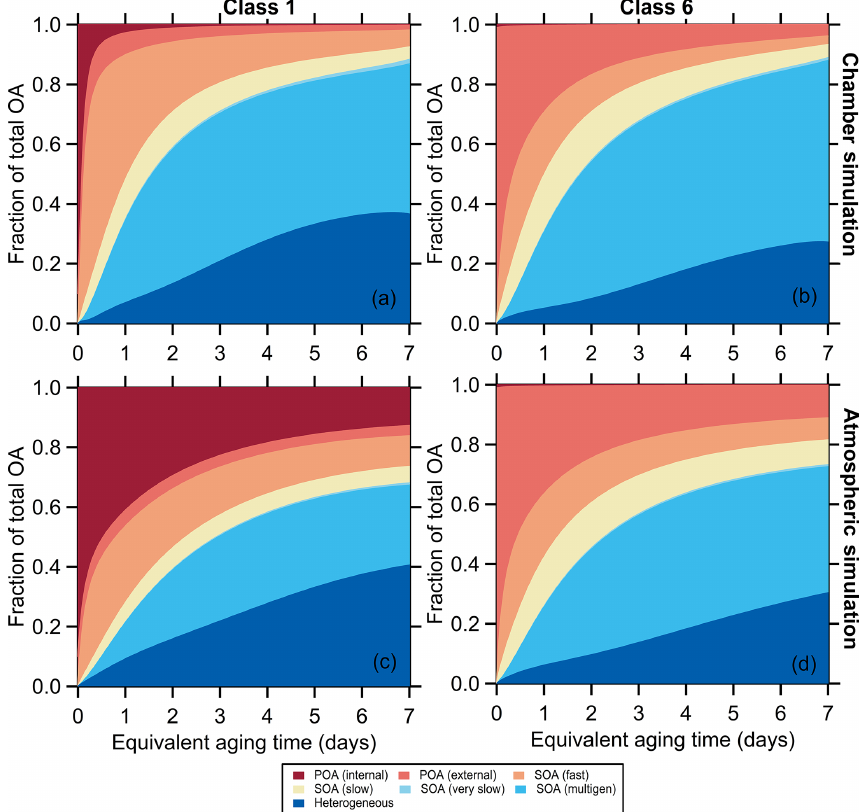
Figure 4. Variation in the simulated OA fractional composition with equivalent aging time for (a, c) SSA class 1 (BC-rich) and (b, d) SSA class 6 (OA-rich) for the mini chamber experiments. For the chamber simulations in panels (a) and (b) the differences in decay rates between particle types and gases are accounted for. For the atmospheric simulations in panels (c) and (d) it is assumed that gases and particles all decay with the same